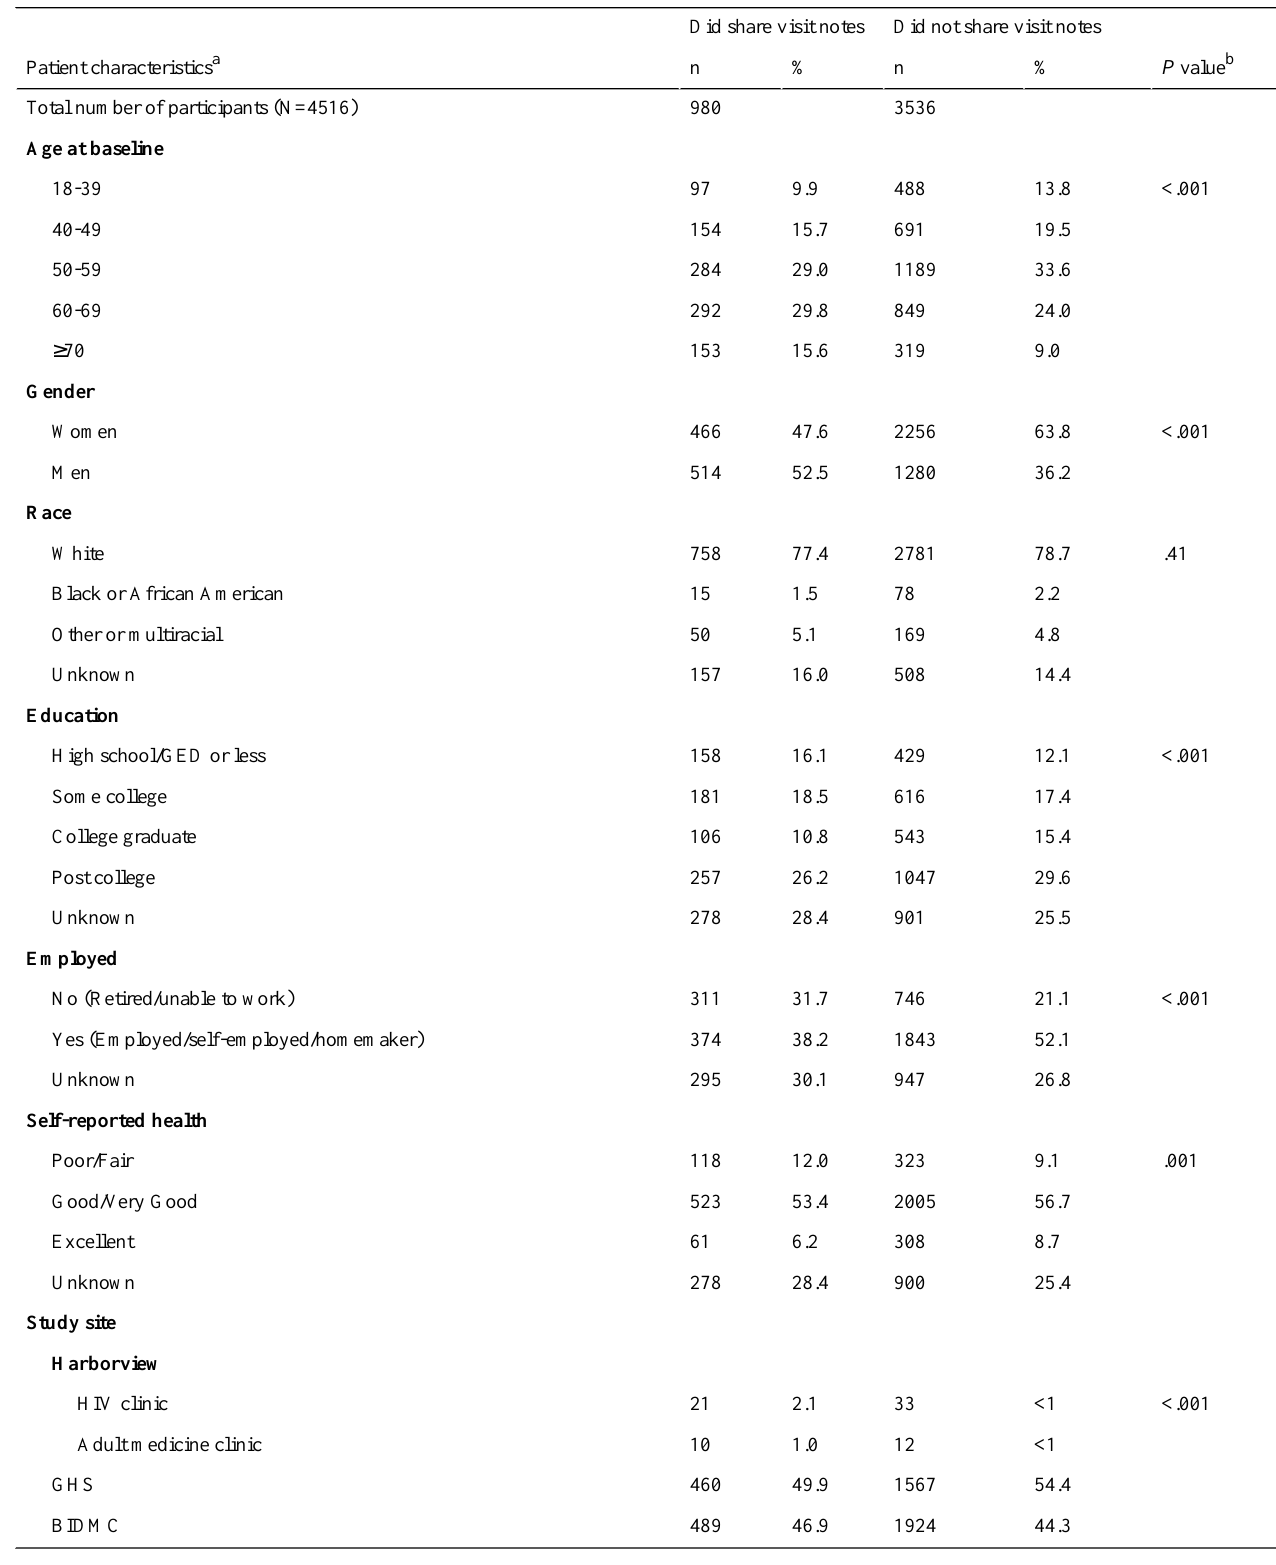
Table 1. Characteristics of patients who reported sharing or did not report sharing their visit notes with someone else during the